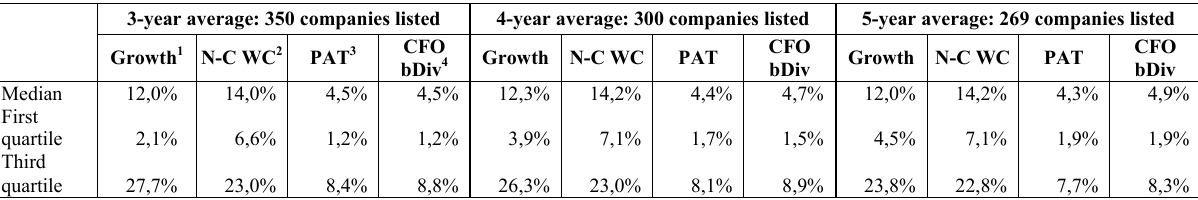
Table 2: Descriptive statistics